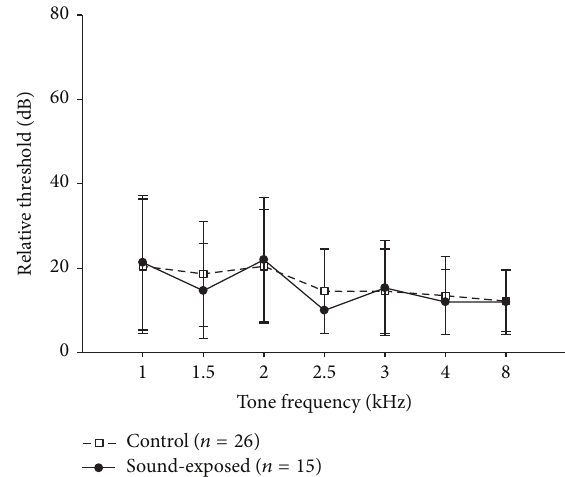
Figure 2: Average ABR thresholds of sound-exposed subjects (filled symbols) at tone-frequencies near the sound-exposure stimulus are not statistically different from those of controls (open symbols). Error bars are ± 1